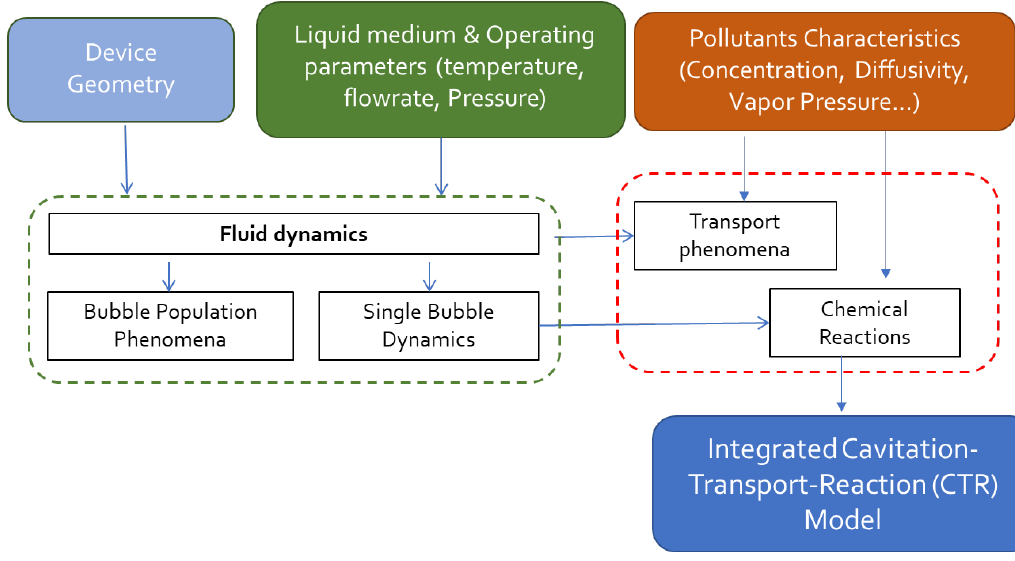
Figure 4. Reactor model for the kinetics estimation.